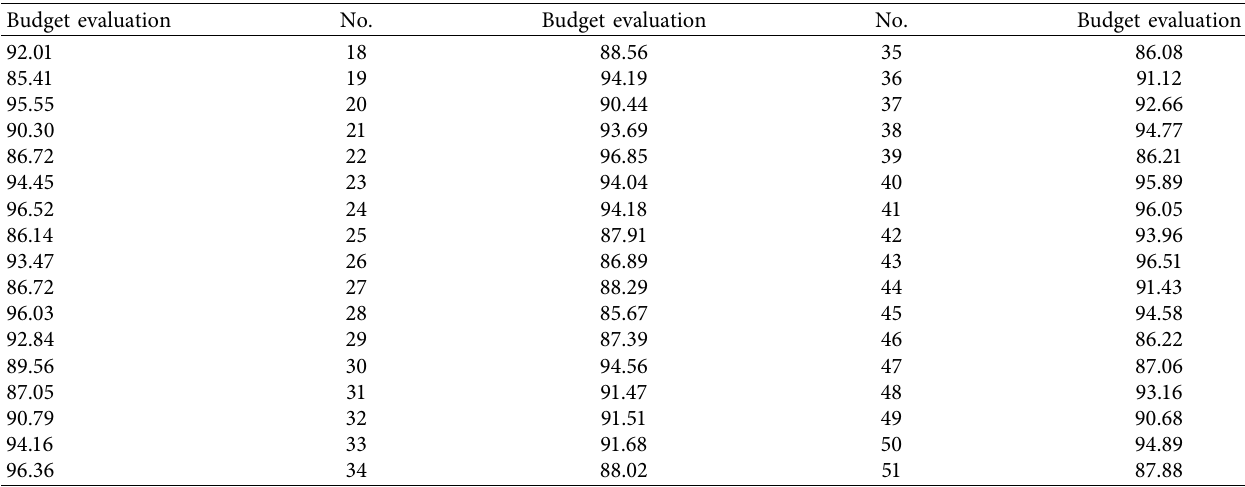
Figure 8: Schematic diagram of departmental budget. Table 3: Evaluation of the effect of the financial budget of the intelligent system colleges and universities.